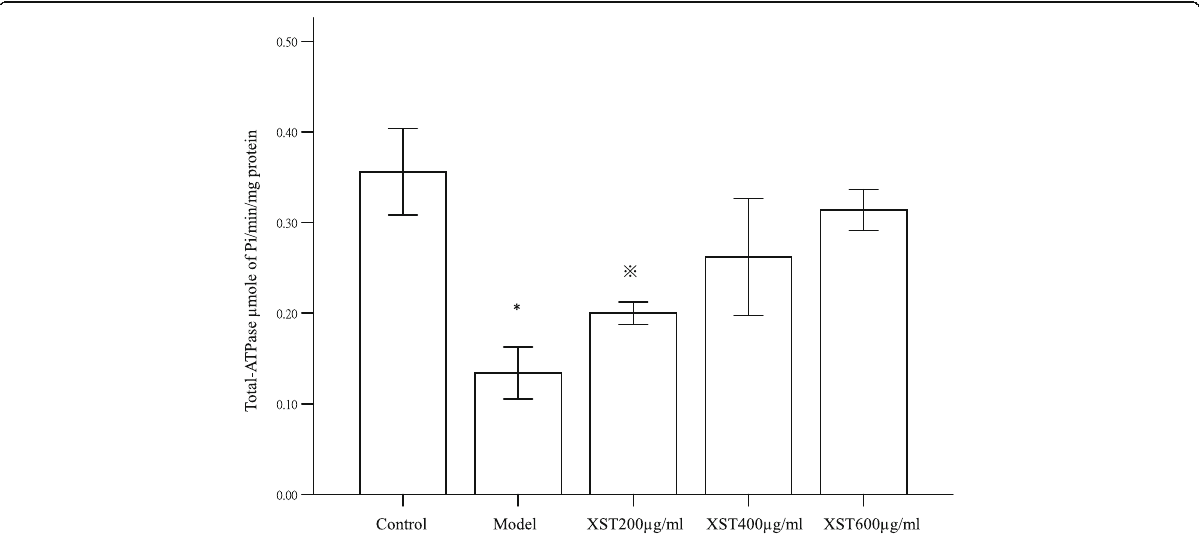
Fig. 6 Mitochondrial ATPase activity in cardiomyocytes was determined by estimating the amount of ATP hydrolysis in terms of inorganic phosphorus (Pi) liberated in the cell supernatant. A significant decrease was found in the model group compared to that in the control. Three XST-treated groups exhibited a dose-dependent increase in the activity as showed in bar graphs. All samples were checked in three